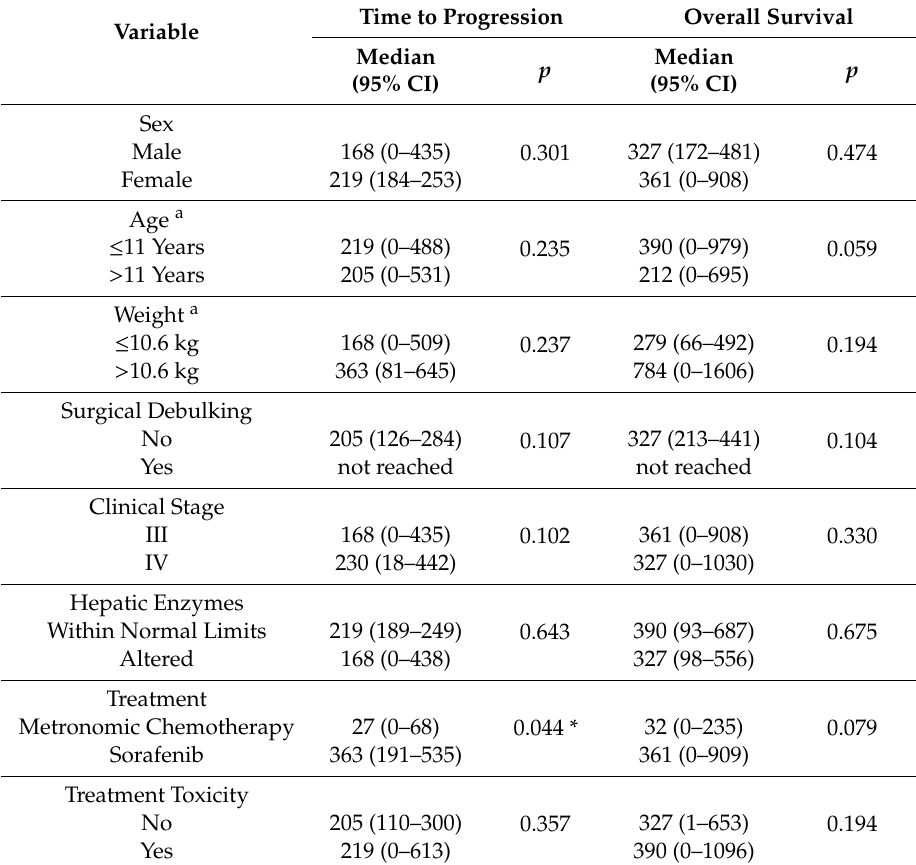
Table 3. Log-rank test for the variables potentially associated with increased risk of tumour progression and overall survival in 13 dogs with hepatocellular